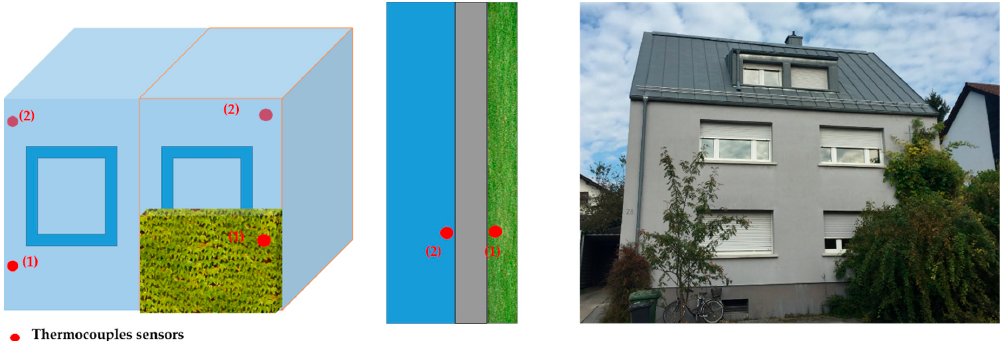
Figure 3. Experiment setup and sensor placement (green roof in Illingen, Germany).